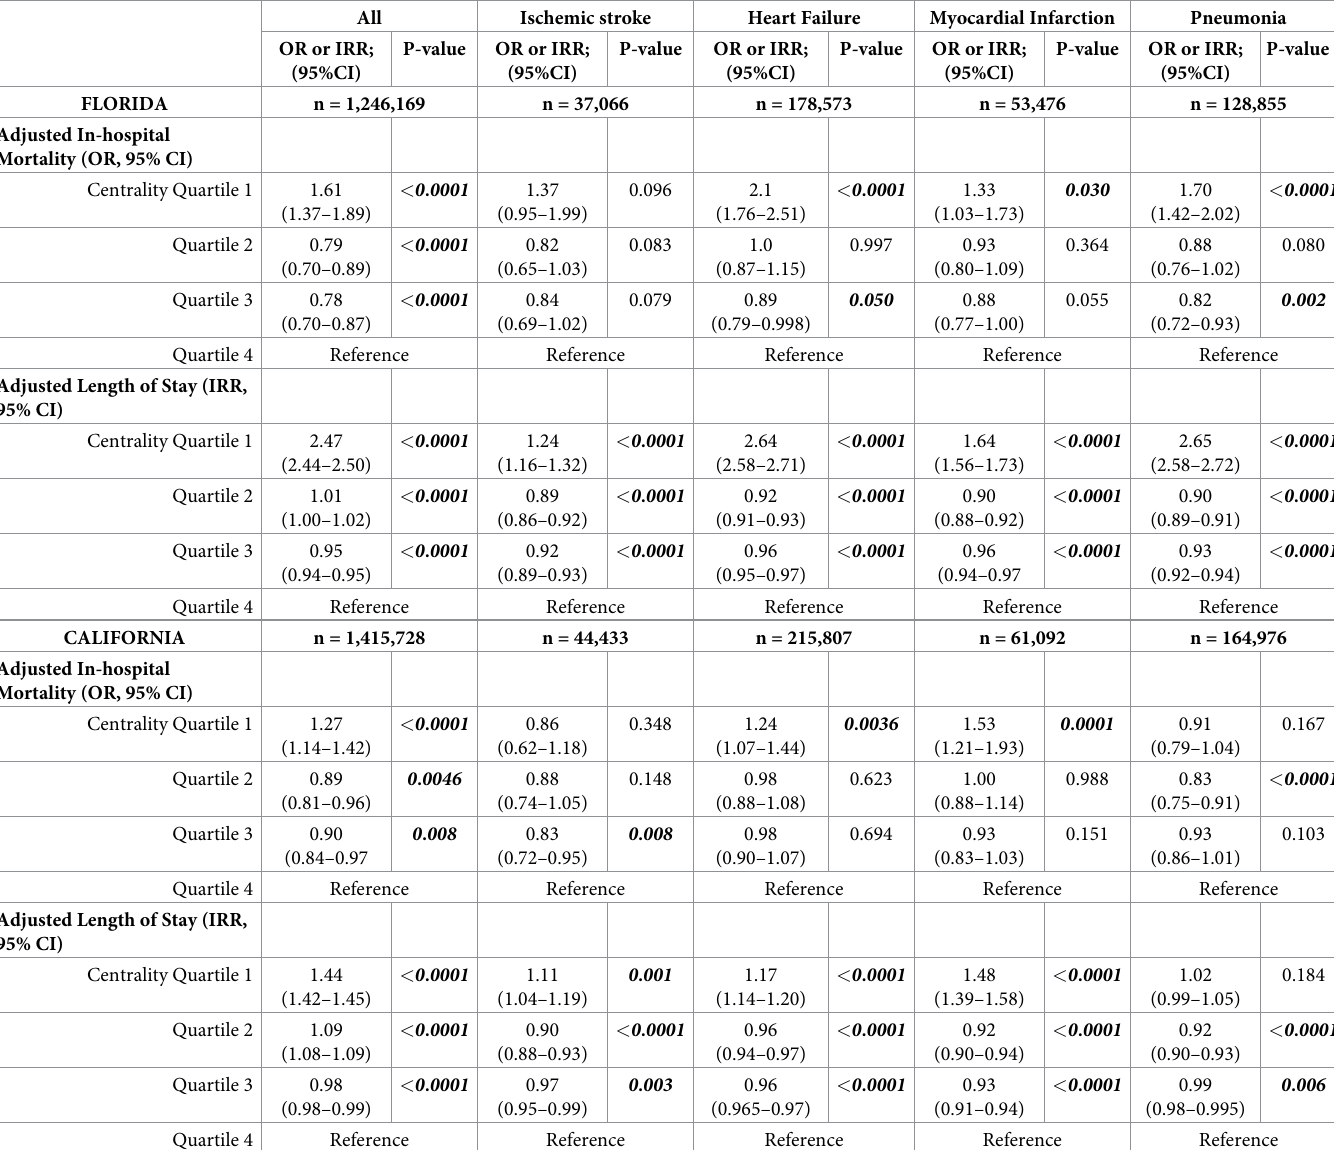
Table 2. Overall and disease–specific adjusted mortality and length of stay by hospital centrality quartile for Florida and